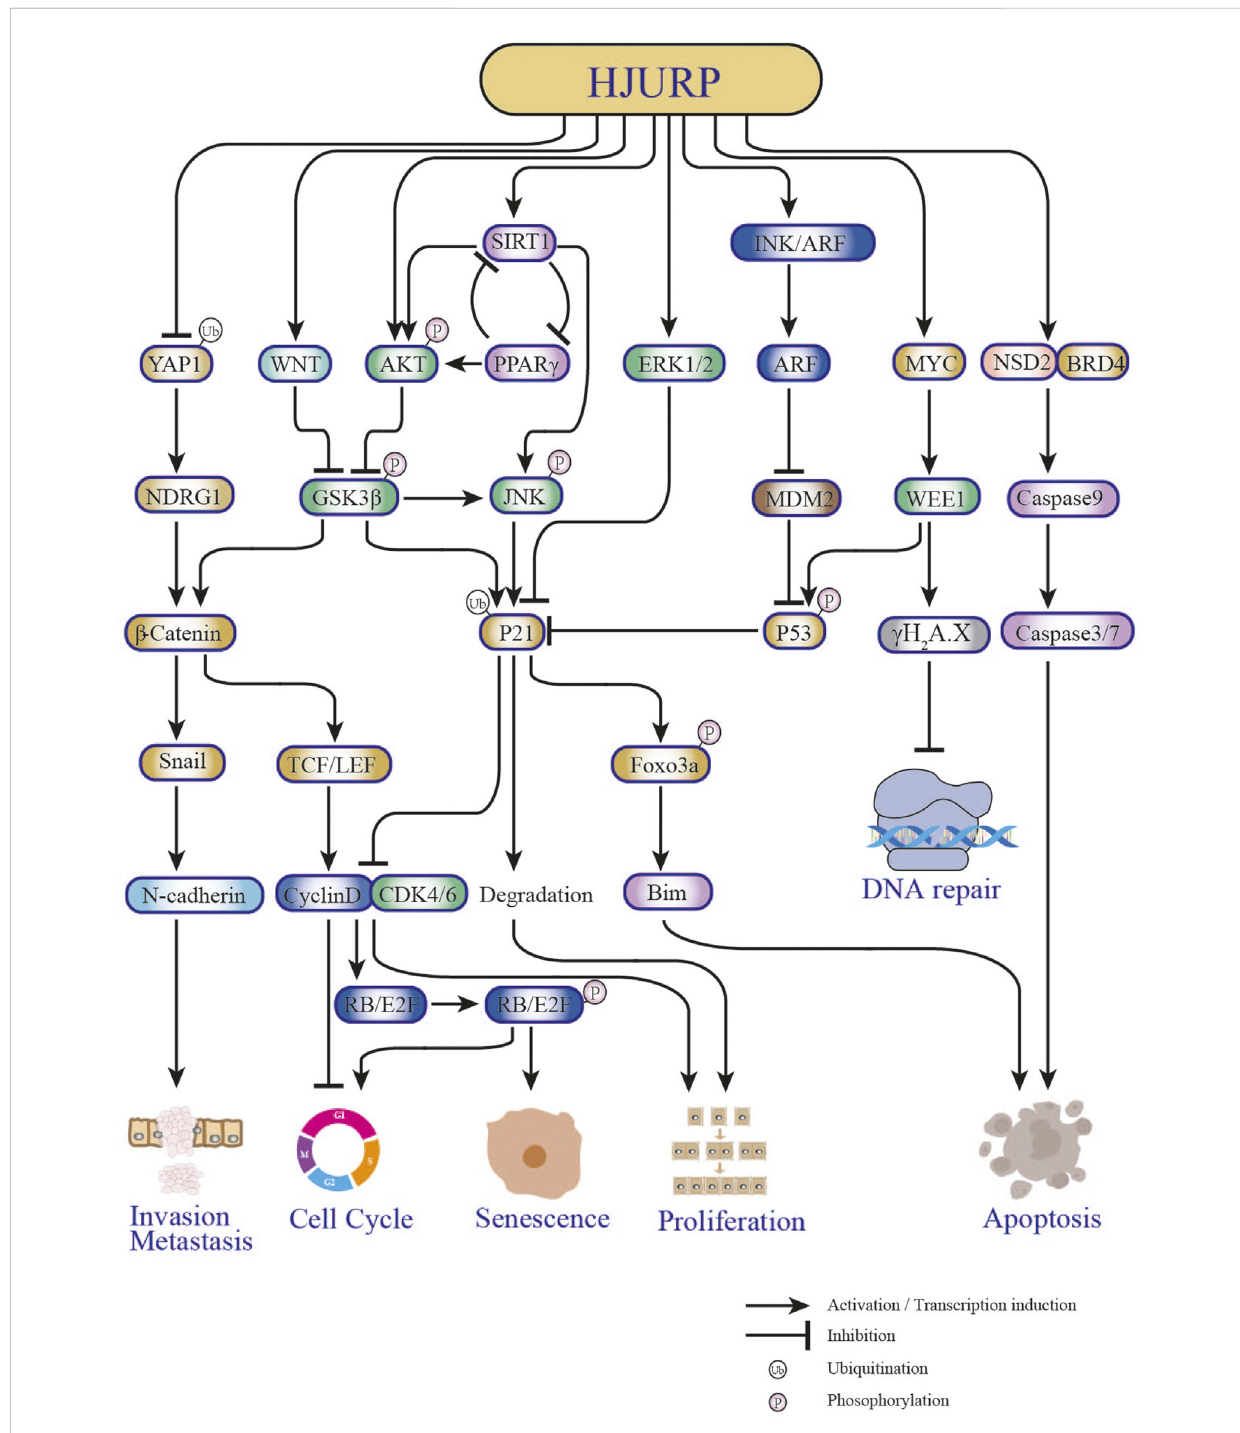
FIGURE 4 Key pathways in tumorigenesis and progression affected by